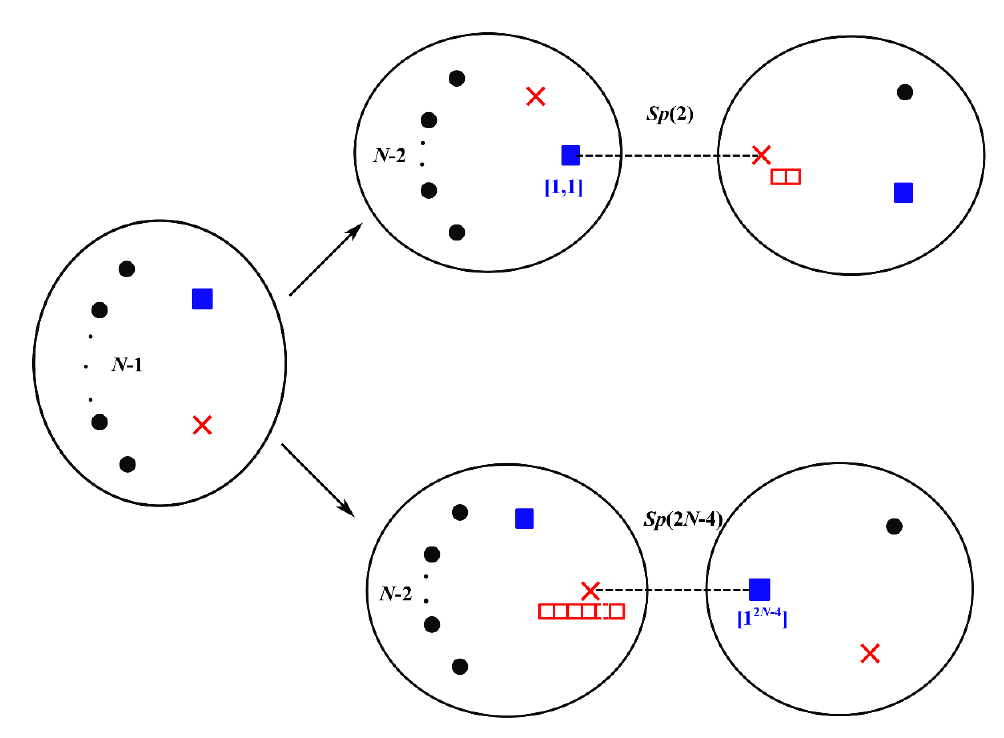
Figure 13 . S-duality for twisted D N theory of class ( k; 1) with large k . Here we present the duality frame recursively by splitting the Argyres-Douglas matter. In the (cid:12)rst line we split a (cid:2) ( k +2) (cid:0) (cid:1) theory III [1;1] ; F with F a full D 2 twisted puncture; in the second line we split a k; 1